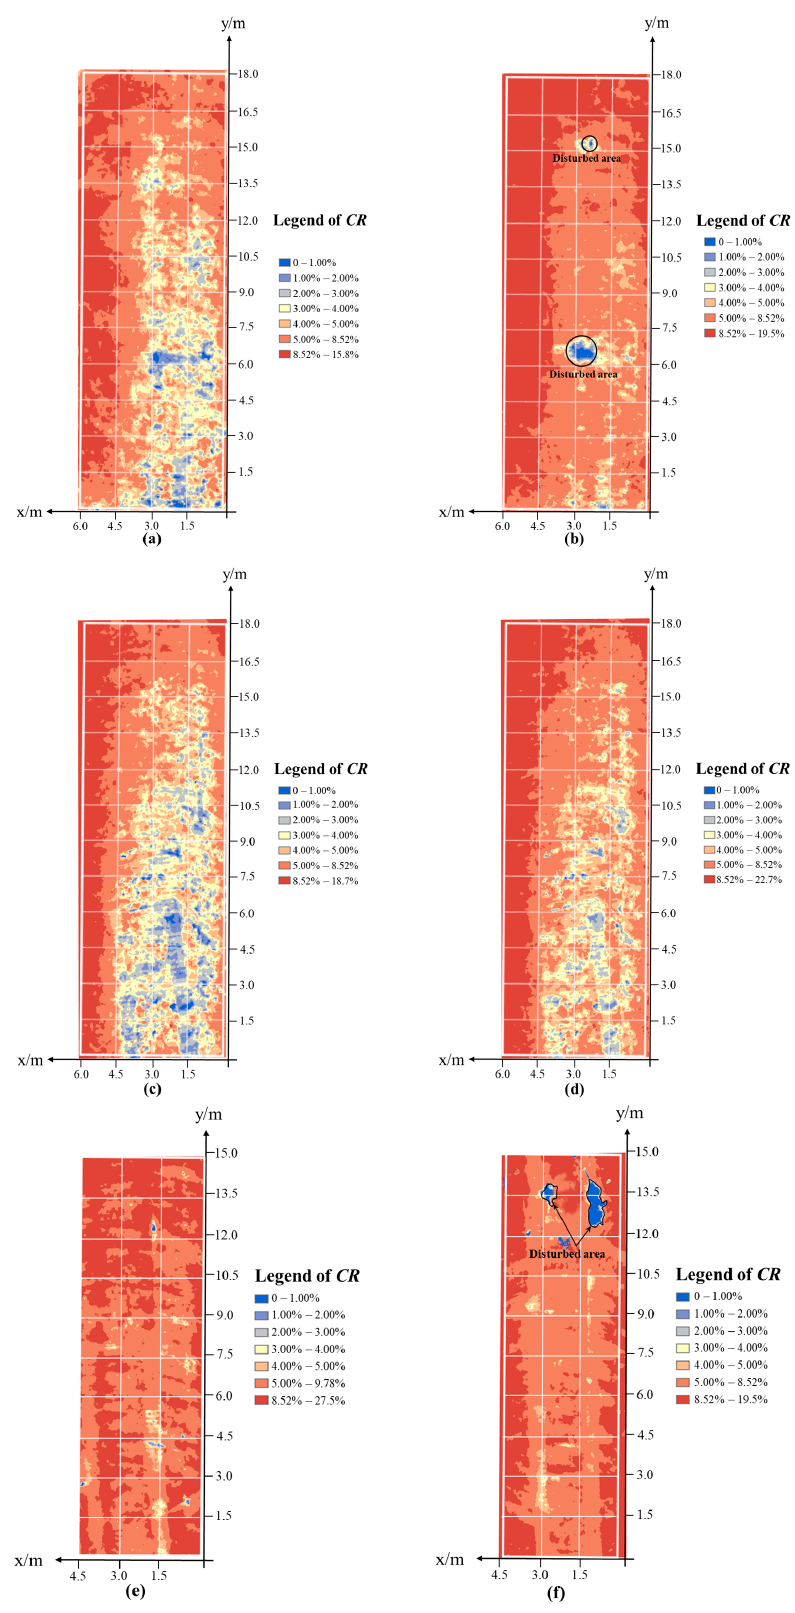
Figure 6. CR nephogram: ( a ) Zone A compacted 8 times; ( b ) Zone A compacted 10 times; ( c ) Zone B compacted 10 times; ( d ) Zone B compacted 12 times; ( e ) Zone C compacted 6 times; and ( f ) Zone D compacted 8 times.